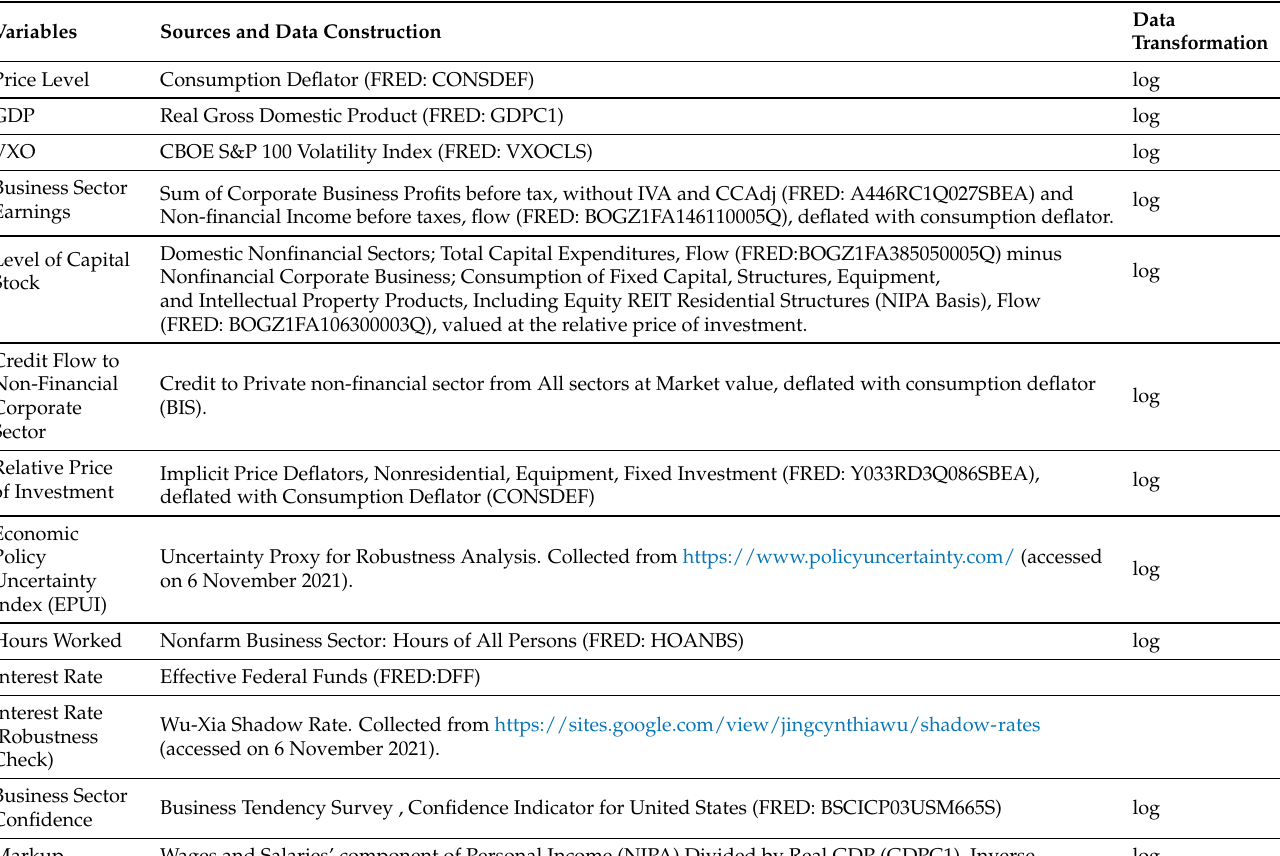
Figure A2. Capital Stock and the VXO. Notes : The figure shows the time-series of the corporate sector earnings along with the proxy of uncertainty. The figure suggests that capital stock is procyclical while the uncertainty proxy is countercyclical. The correlation coefficients between the VXO and firms’ earning is − 0.21. Both series are normalized. Table A1. Construction of Variables used in the Empirical